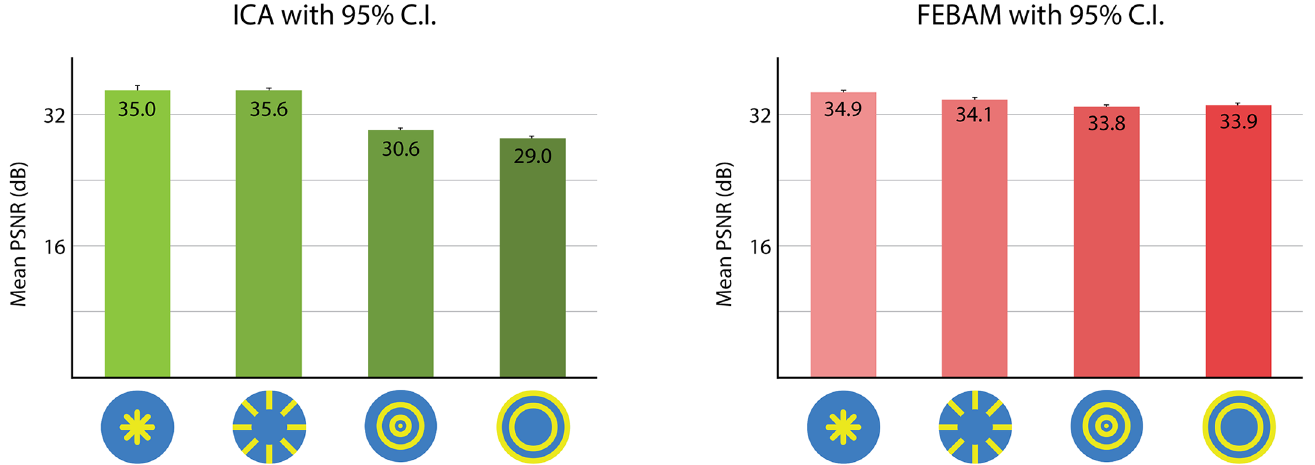
Fig 3. ICA & FEBAM model results for pattern positioning and pattern type. PSNR values for pattern type and positioning. Each pattern in the figure was reconstructed using its own filters generated by either the ICA or FEBAM models, and the quality of this new image was compared to the original image. Results are based on 300 simulations. Error bars show 95% confidence interval. The test patterns in the figure were used in a behavioural experiment elsewhere.